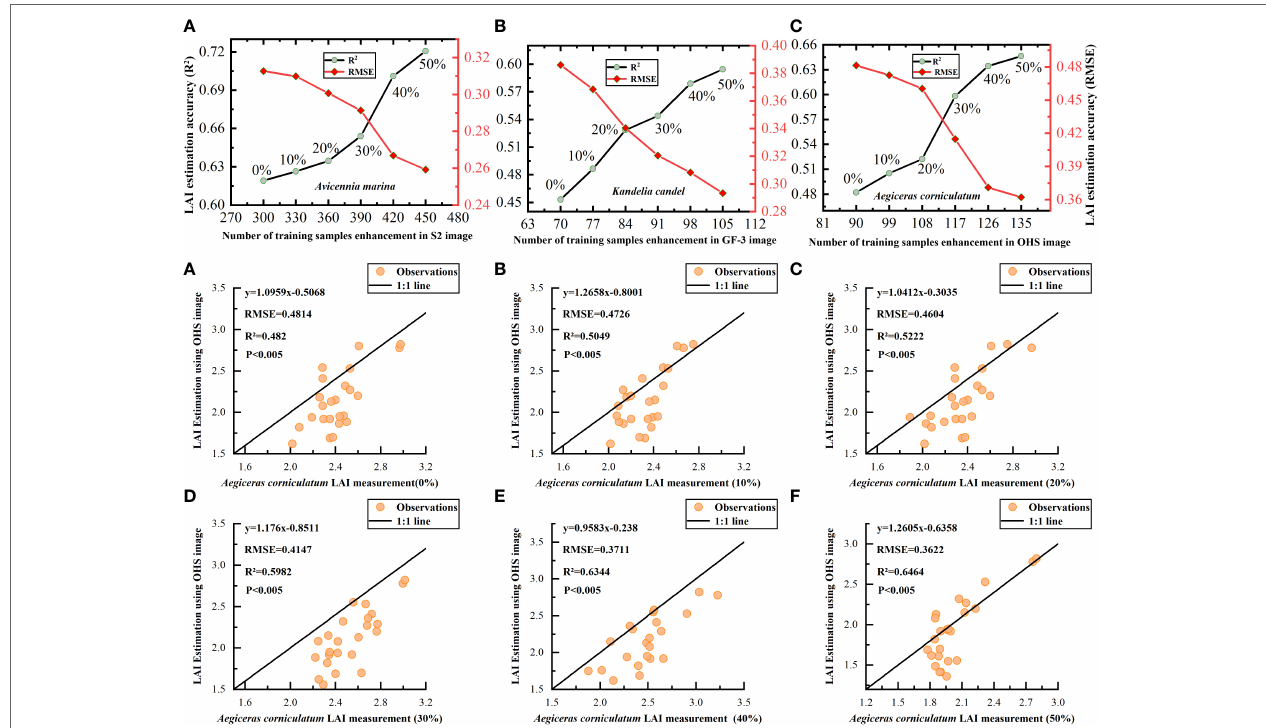
FIGURE 9 | Estimating mangrove LAI using the Transformer model under different sample expansion ratios. (A–C) Represents the variation trend of the estimation accuracy of the Transformer model for the LAI of 'Avicennia marina', 'Kandelia candel' and 'Aegiceras corniculatum' under S2,GF-3 and OHS image data with the enhancement of training sample data. (A–F) Indicates the variation trend of the estimation accuracy of the Transformer model for the LAI of 'Aegiceras corniculatum' under the OHS image data, with the increase of the training sample expansion ratio